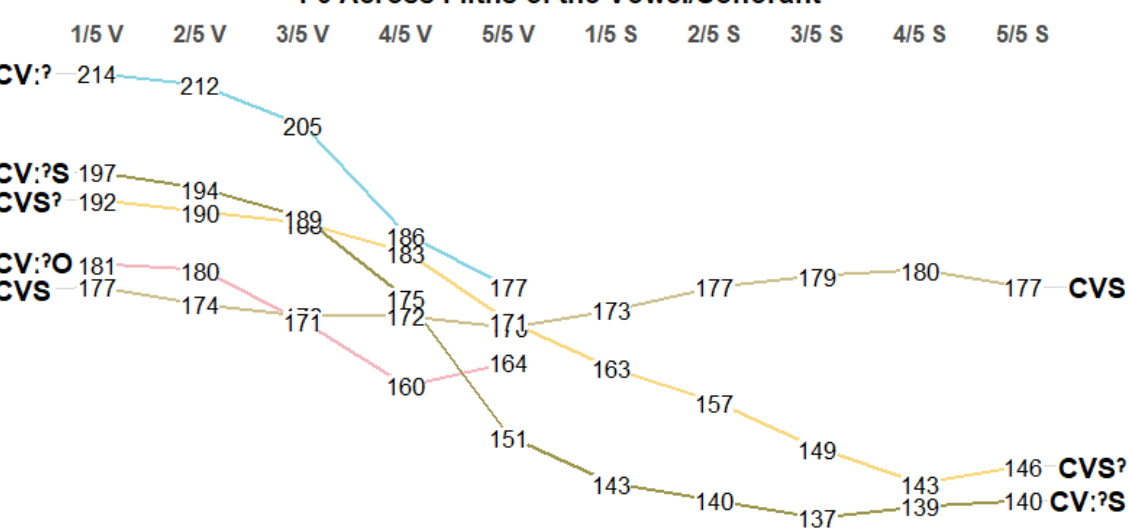
Figure 6. Average F0 in Hz across fifths of the vowel/sonorant by word type. ‘V’ indicates intervals of the vowel and ‘S’ indicates intervals of the sonorant. Numbers represent the average F0 in Hz per interval. For CV ːˀ and CV ːˀ O words without sonorant coda consonants, the F0 contours end at the 5/5 V mark.